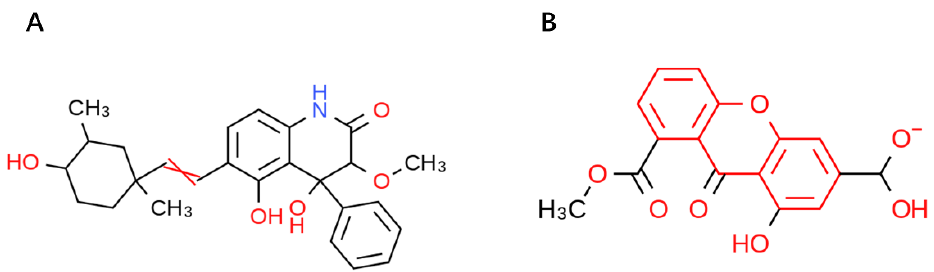
Figure 8. Toxicity alerts for compounds 44 and 31 are displayed in red font. Toxicity alerts for compounds 44 and 31 are displayed in red font. ( A ) Toxicity alert for compound 44 ; ( B ) toxicity alert for compound 31 .